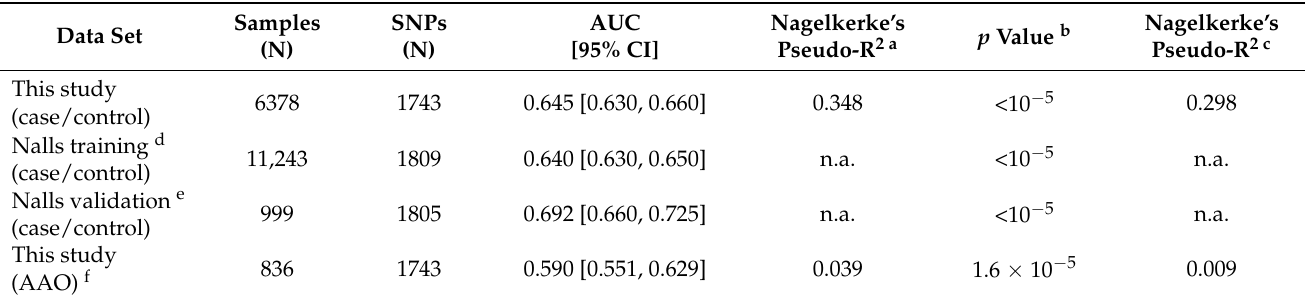
Figure 1. PD-PRS in PD cases and controls. ( A ) Density of PD-PRS in cases and controls. ( B ) ROC curve for PD-PRS as a predictor of case-control status. PRS: polygenic risk score, PD: Parkinson’s disease, ROC: receiver operating characteristic. Table 1. Comparative validation of